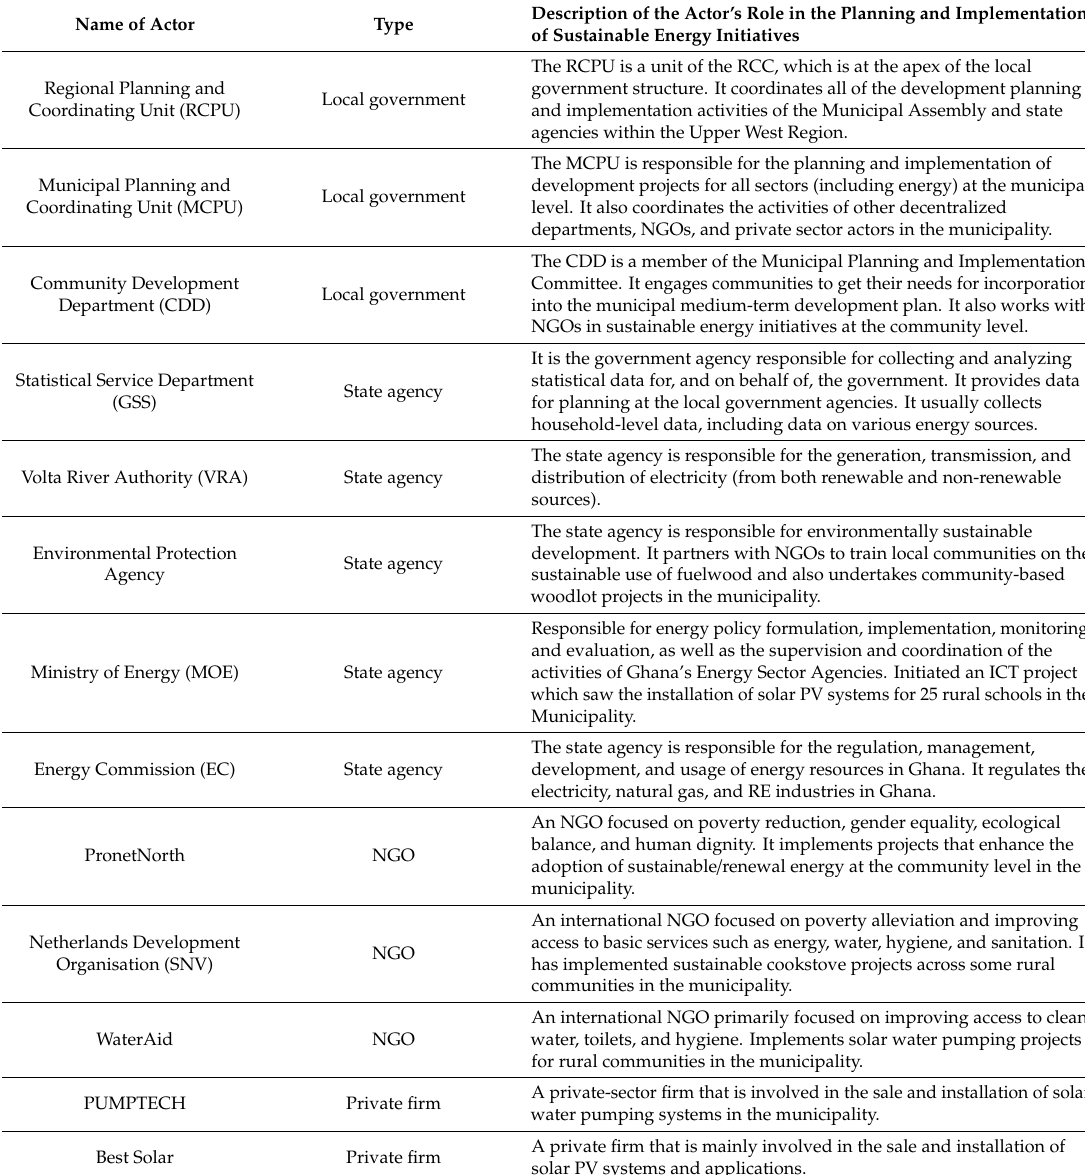
Table 1. Types of local actors and the nature of their involvement in SET